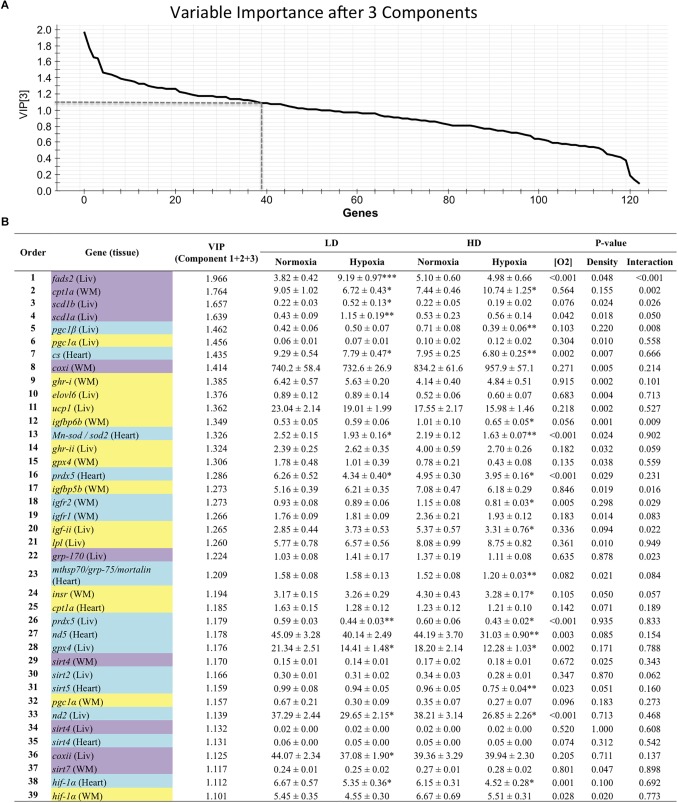
(A) Graphical representation of the variable importance (VIP) scores after component 3. (B) Ranking list of genes showing VIP score values above 1.1 and their relative gene expression. Cells shaded in blue highlight genes detected as VIP after component 1; cells shaded in yellow highlight genes detected as VIP after component 2; and cells shaded in purple highlight genes detected as VIP after component 3. For further details, see legend on Figure 2.